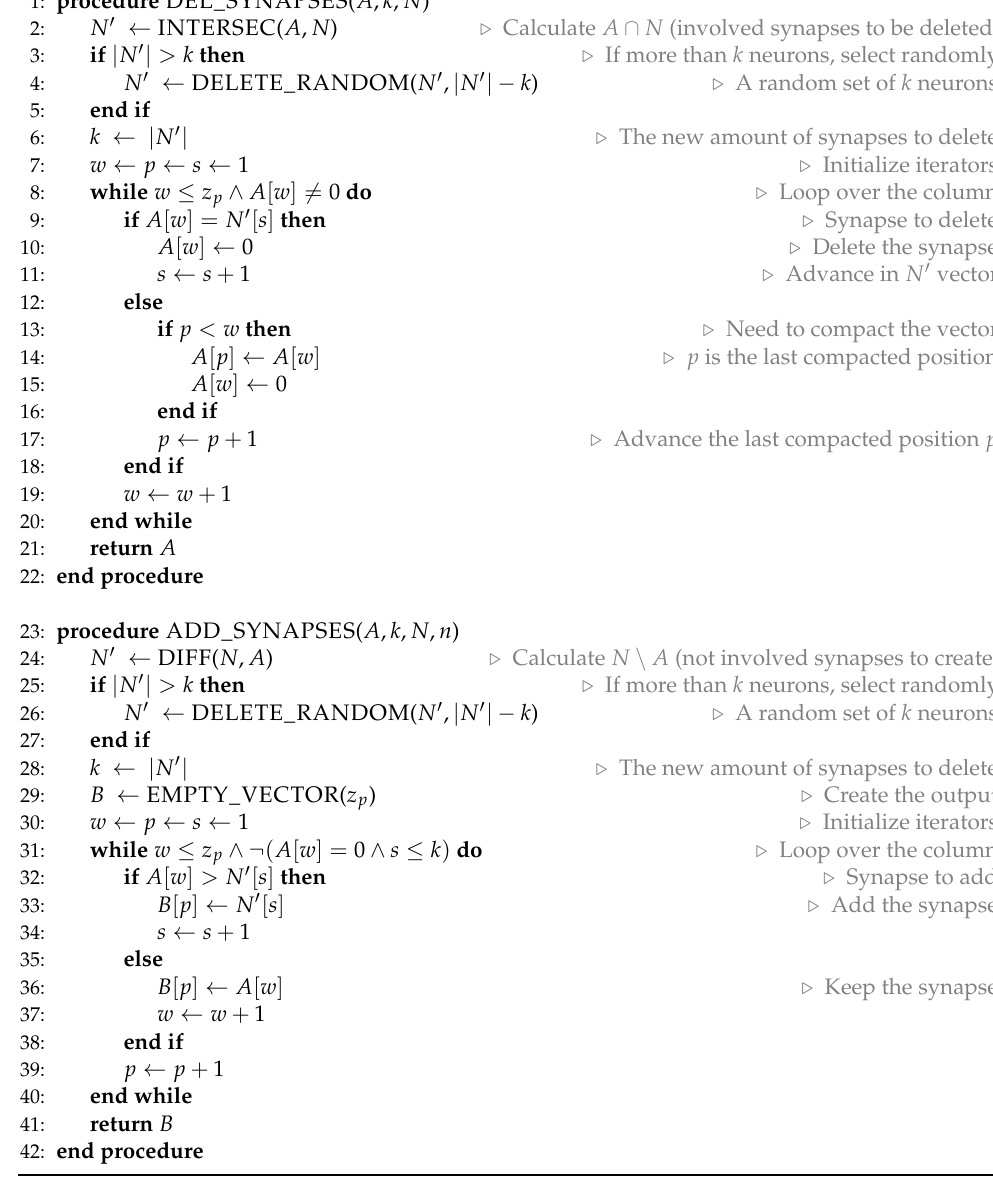
Algorithm 12 Auxiliary functions for plasticity mechanism using optimized compressed matrix representation.